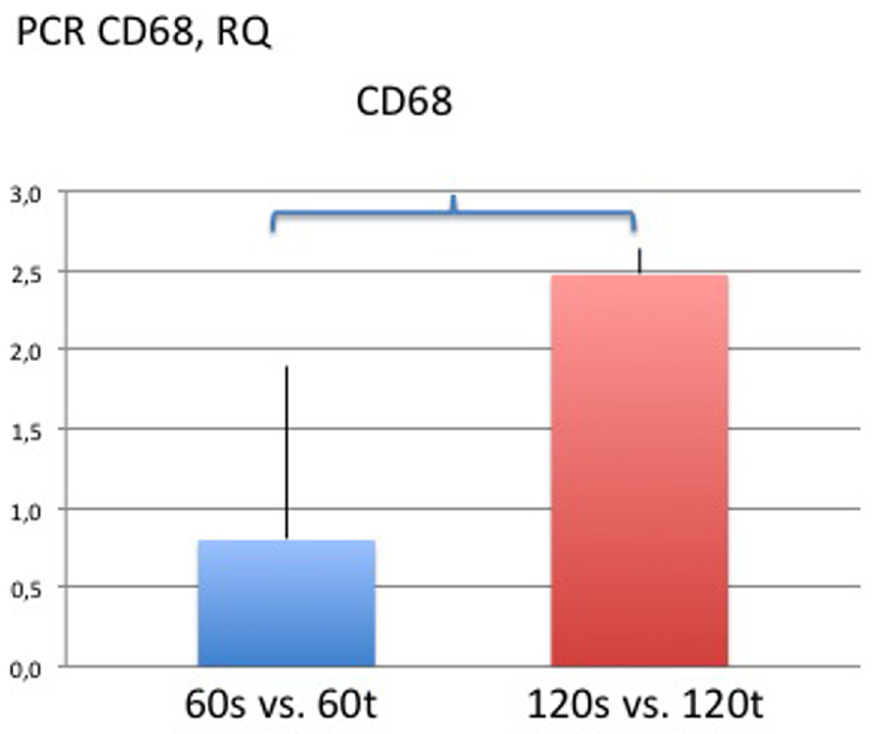
Fig 15. Results of quantitative real time PCR for CD68 given in fold change compared to textured implant group of day 60 or 120, respectively. Asterisks and brackets indicate statistical significance and P < 0.05 was considered statistically